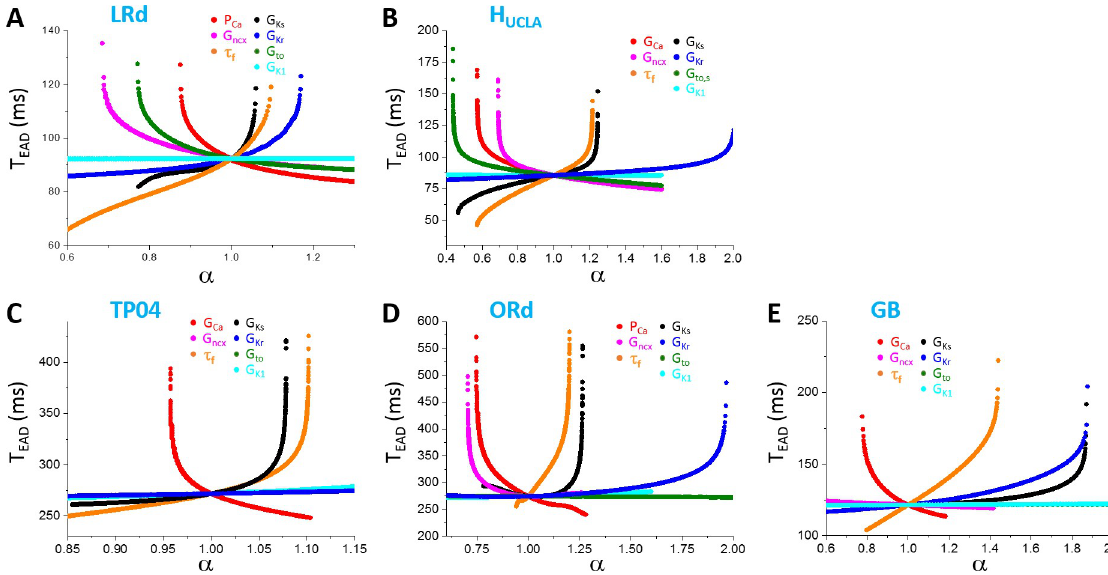
Fig 7. Dependence of T EAD on maximum conductance and kinetics of ionic currents in different models. A . LRd. B . H UCLA . C . TP04. D . ORd. E . GB. Only the first T EAD (the interval between the first and the second EAD) are plotted. One parameter (indicated by color) was changed while the others were set at their control